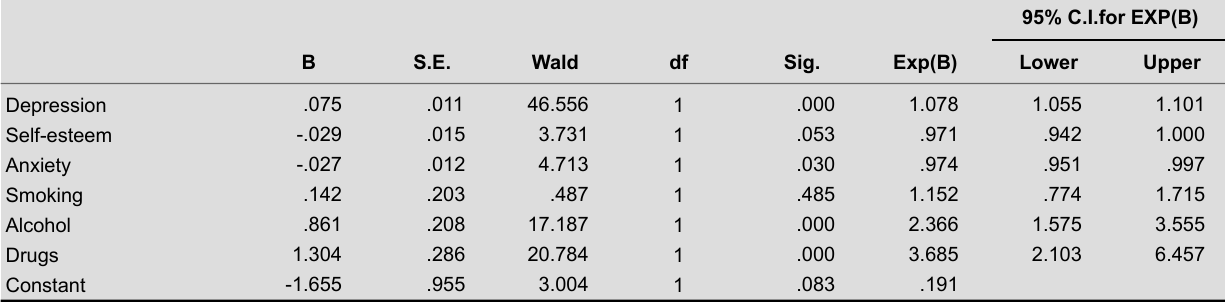
Predicting the Probability of Being Classified as Sexual